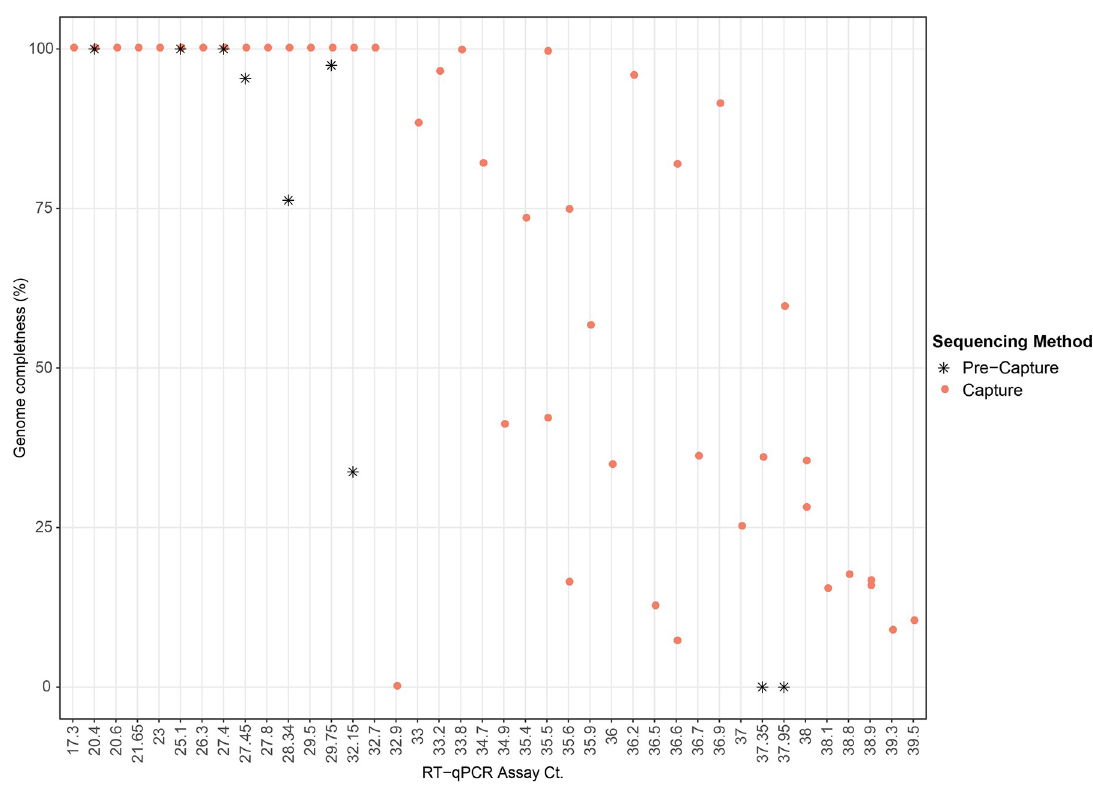
Fig 3. Scatter plot showing genome completeness as a function of Ct value. Pink circles represent post-capture samples and black asterisks represent pre-capture samples.